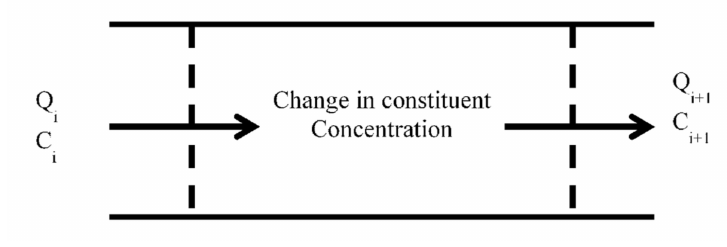
Figure 3. Control volume representing the mass balance